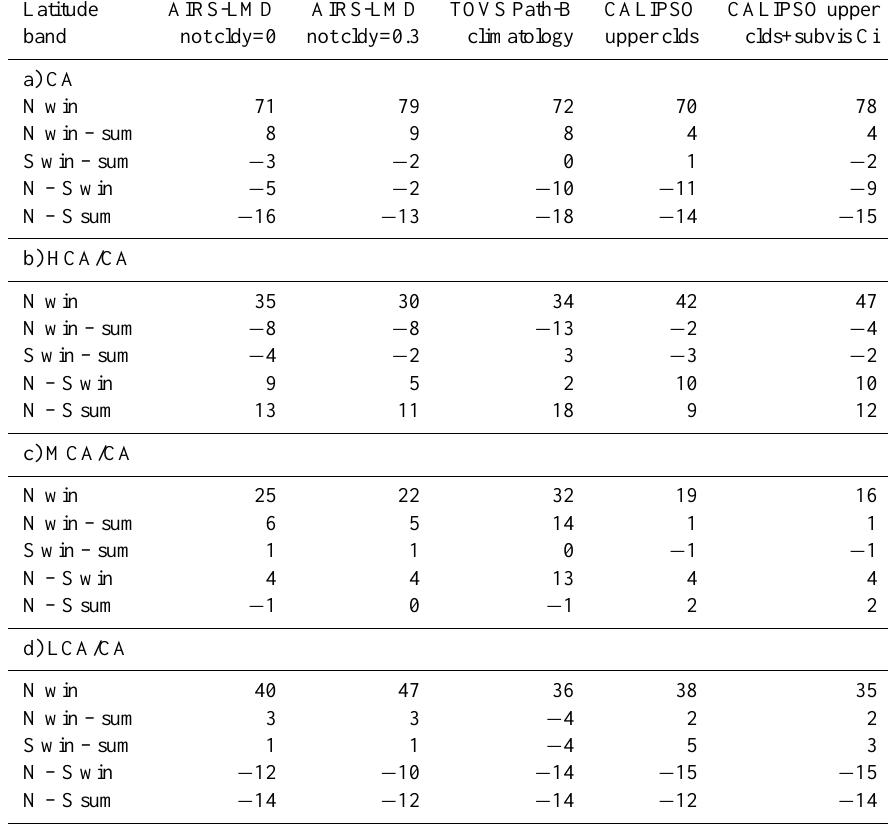
Table 3. Cloud amount averaged over NH midlatitudes (30 ◦ N–60 ◦ N) in winter, and differences between winter and summer in NH mid- latitudes, winter and summer in SH midlatitudes (30 ◦ S–60 ◦ S), between NH midlatitudes and SH midlatitudes winter and between NH midlatitudes and SH midlatitudes summer. Results are shown from AIRS-LMD, TOVS Path-B and CALIPSO as in Table 2: a) total (CA), b) high, c) midlevel and d)